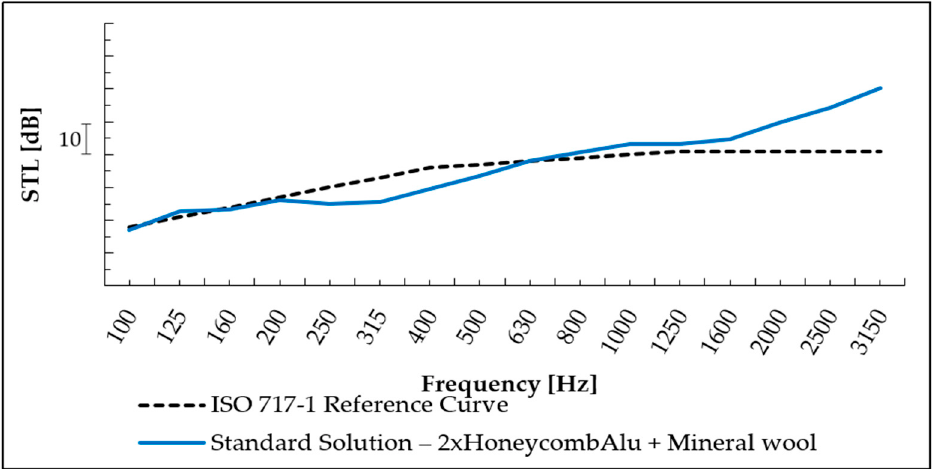
Figure 3. Benchmark solution experimental STL and ISO 717-1 reference curve for Rw calculation.